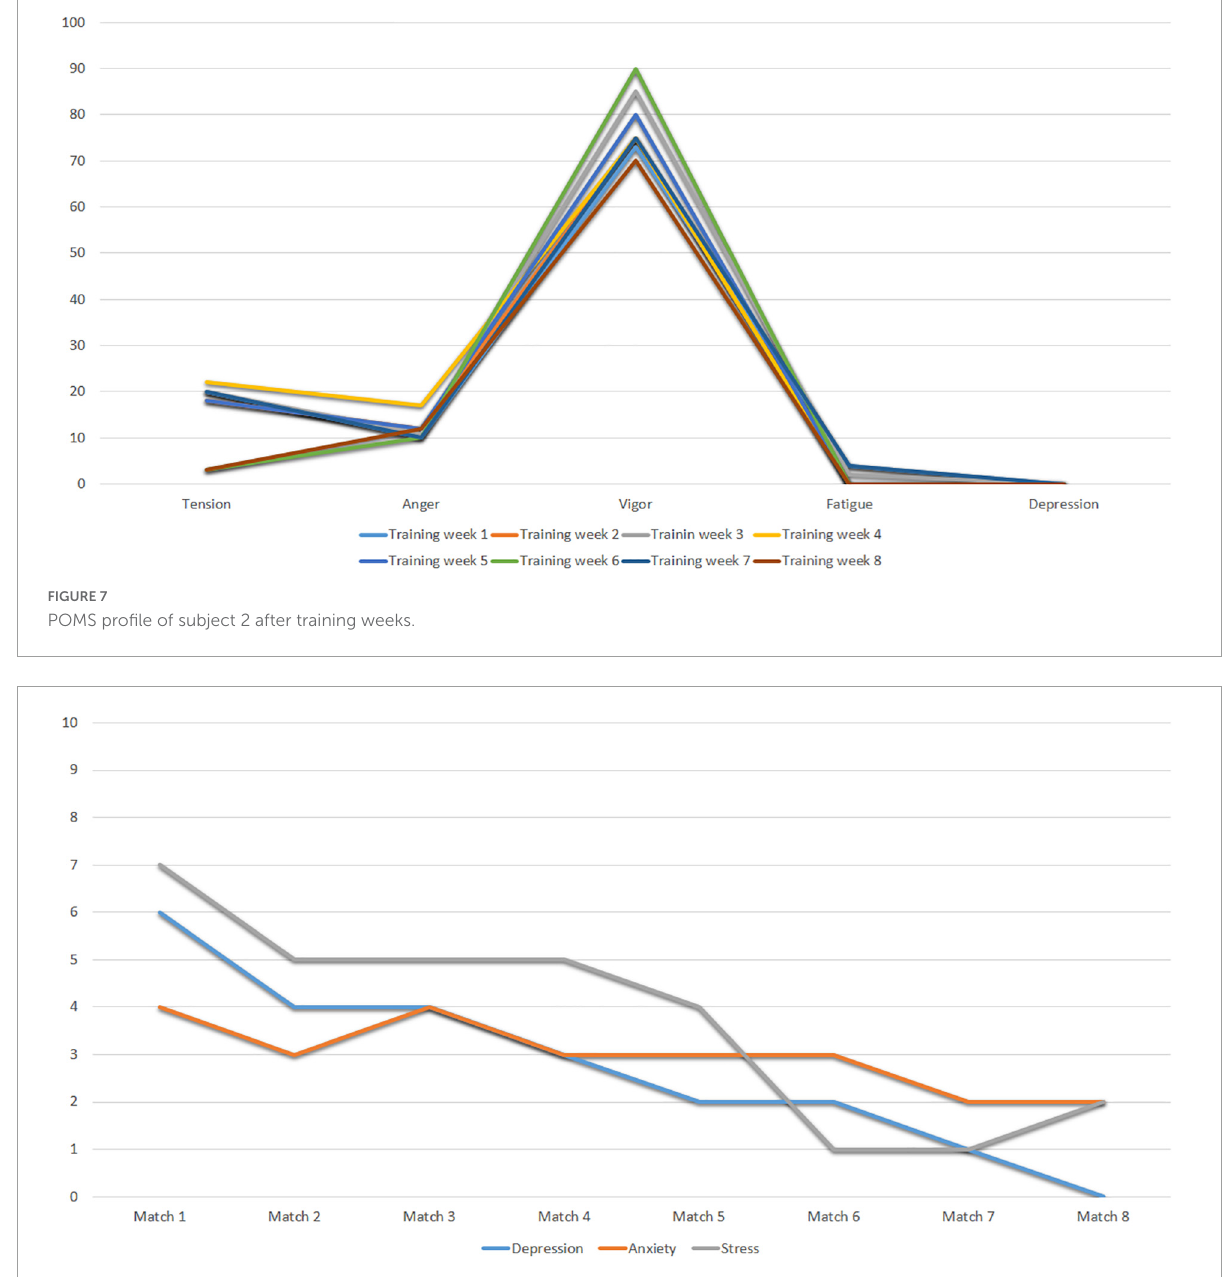
FIGURE8 Scores of subject 2 to the subscales of the